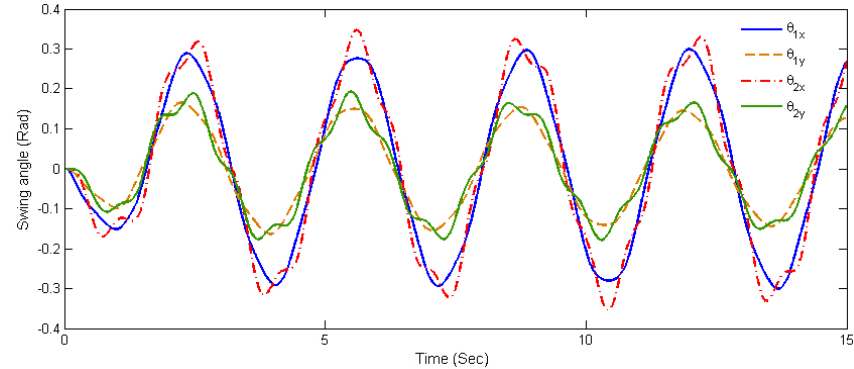
Figure 3. Dynamic response of 3-D double pendulum gantry crane with 4 degree of freedom.